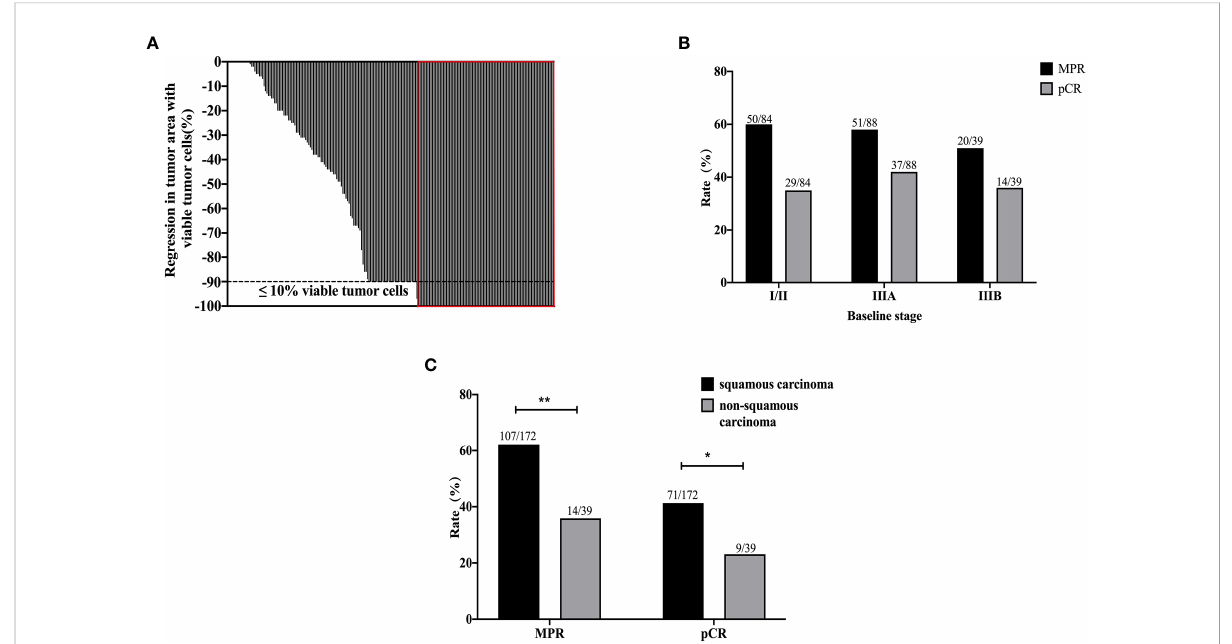
FIGURE 2 The pathological results of all 211 patients after neoadjuvant immunotherapy plus chemotherapy. The depth of pathological regression of all patients (A) . The MPR and pCR results by baseline stages of disease (B) . The MPR and pCR results of squamous carcinoma and non-squamous carcinoma (C) . **p < 0.01; *p <